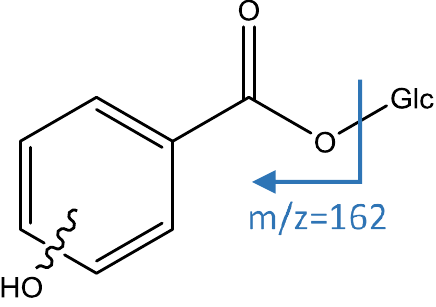
Figure 3. Structure and fragments of acid derivatives (6) and (9).